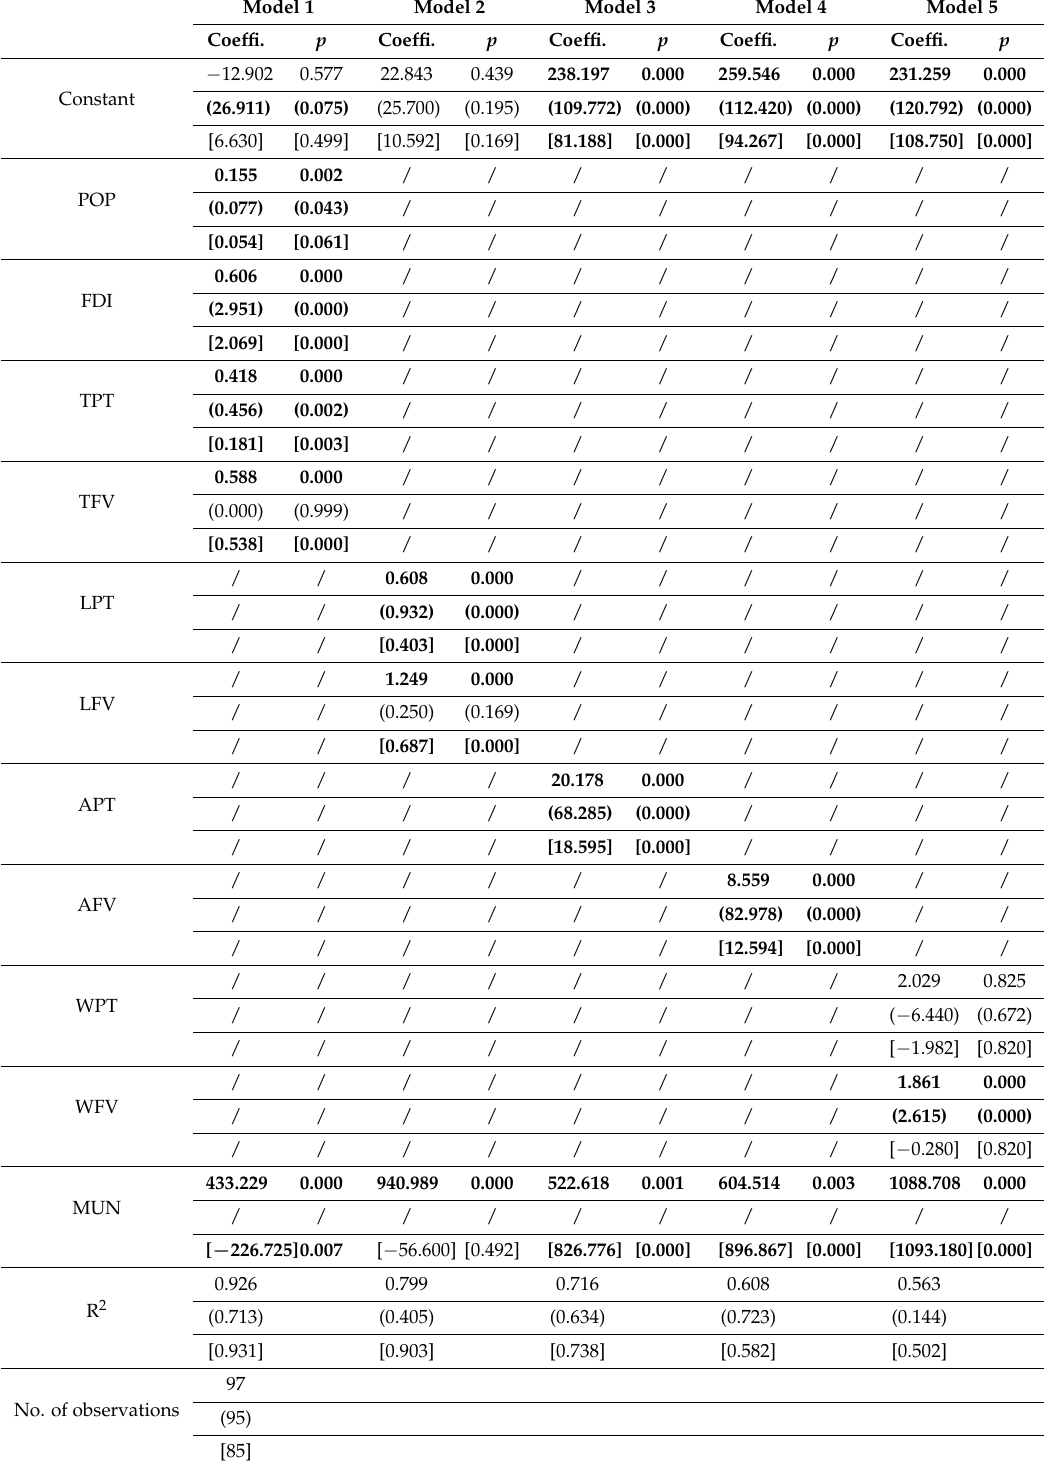
Table A1. Non-spatial model estimation